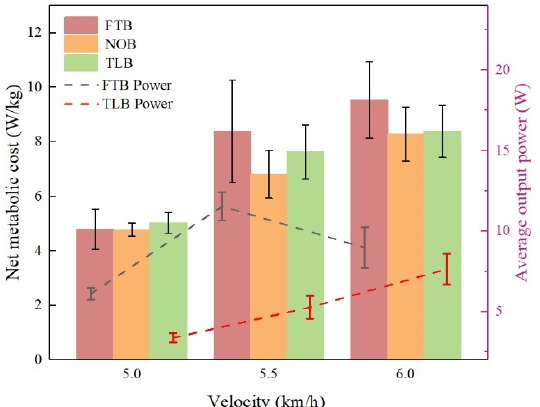
Figure 6. Net metabolic cost and average output power of walking for each condition. Data are means ± SD.